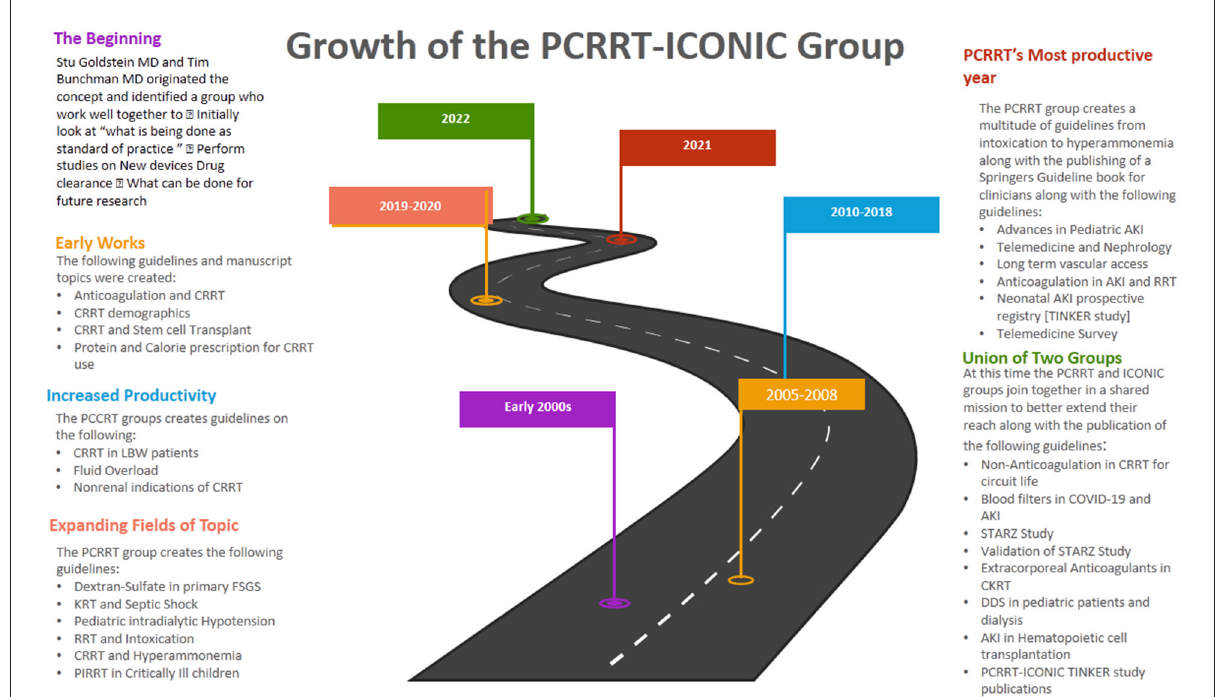
FIGURE1 A roadmap of the formation of the PCCRT-ICONIC group and previous topic areas covered in guidelines and manuscripts written by group members. AKI, Acute kidney injury; CRRT, Continuous renal replacement therapy; DDS, Dialysis disequilibrium syndrome; LBW, Low-Birth weight; FSGS, Focal segmental glomerulosclerosis; PIRRT, Prolonged intermittent renal replacement therapy; STARZ, Sethi, Tibrewal, Agarwal, Raina, and Wazir; TINKER, The Indian PCCRT-ICONIC neonatal kidney education